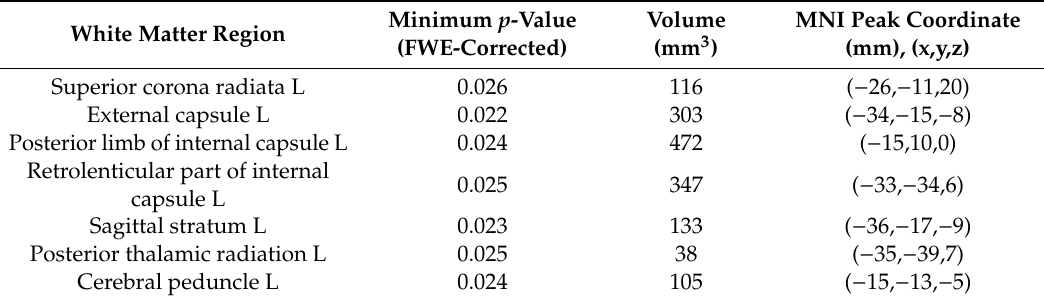
Table A2. White matter regions from the ICBM-DTI-81 White Matter Atlas for which significant increased AD values were found in EM compared to HC including the duration of the migraine as a covariate.